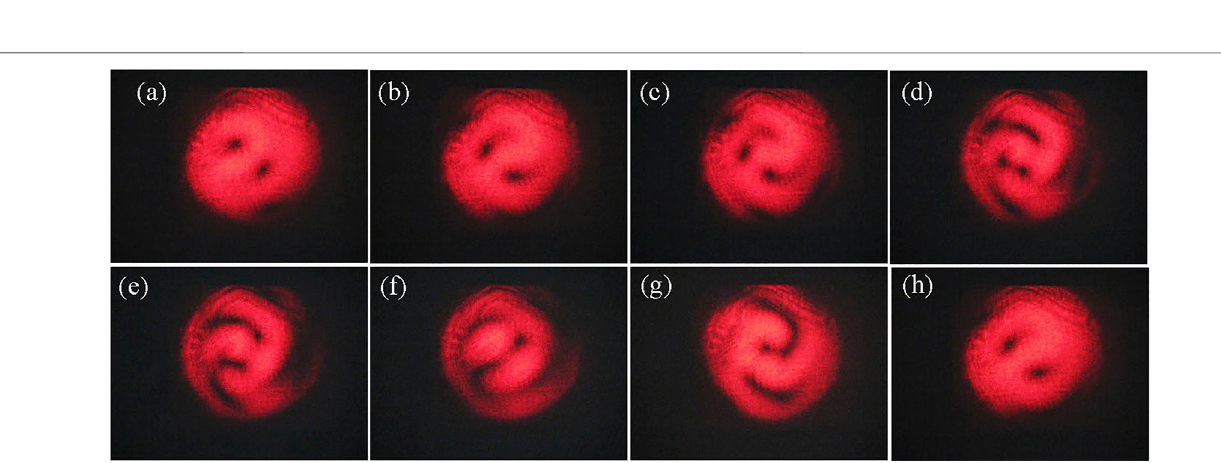
FIGURE 4 | Field distributions at the biaxial crystal output in the vicinity of the optical axis O (both optical axes lie in the plane XZ so that x (cid:1) 0 corresponds to the middle direction between the axes); the input beam polarization makes an angle 45 ° with the axis X : (A) intensity distribution after the output X -oriented polarizer (background) and the transverse orbital fl ow (Eq. 6) component of the X -polarized component (black arrows); (B) spin density (Eq. 8) of the total output fi eld (background), spin fl ow (Eq. 7) map (cyan arrows), and polarization distribution (gray ellipses) [29].